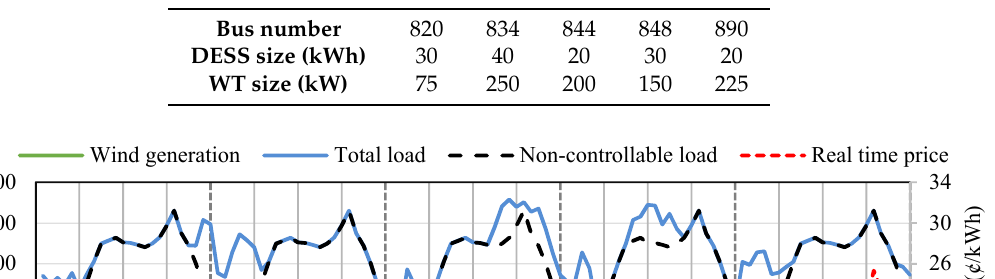
Table 3. System optimization results with 10% controllable load.